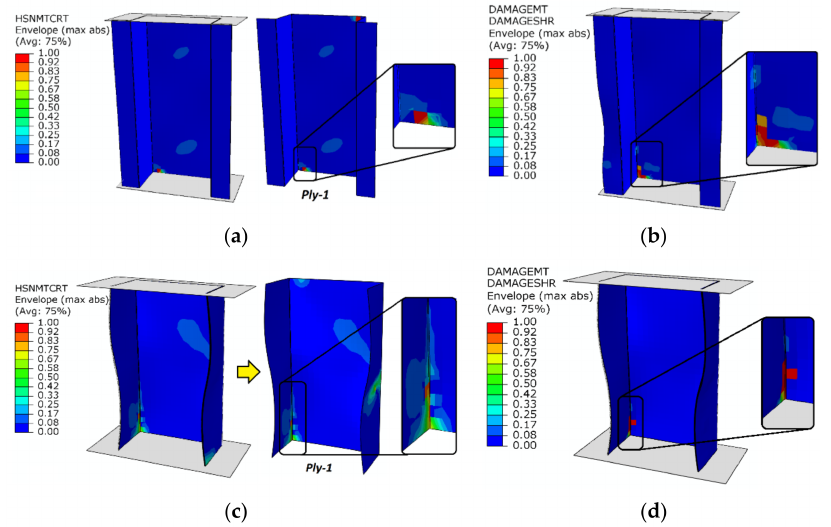
Figure 7. Damage initiation and evolution (PFA)—envelope result from eight laminate plies: ( a ) damage initiation of top-hat column—HSNMTCRT; ( b ) damage evolution of top-hat column— DAMAGEMT and DAMAGESHR; ( c ) damage initiation of channel column—HSNMTCRT; ( d ) dam- age evolution of channel column—DAMAGEMT and